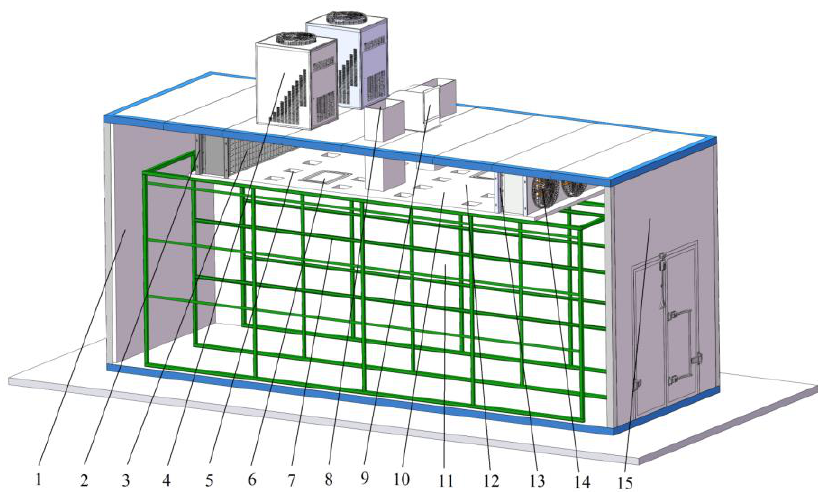
Figure 1. Structure of bulk tobacco curing barn. 1. Left wall; 2. Left fan unit; 3. Left radiator; 4. Heat pump; 5. Air holes; 6. Emergency gate; 7. Steel frame; 8. Moisture discharged holes; 9. Inlet; 10. Polyurethane foam sandwich panel; 11. Tobacco curing chamber; 12. Air return chamber; 13. Right radiator; 14. Right fan unit; 15. Right wall.